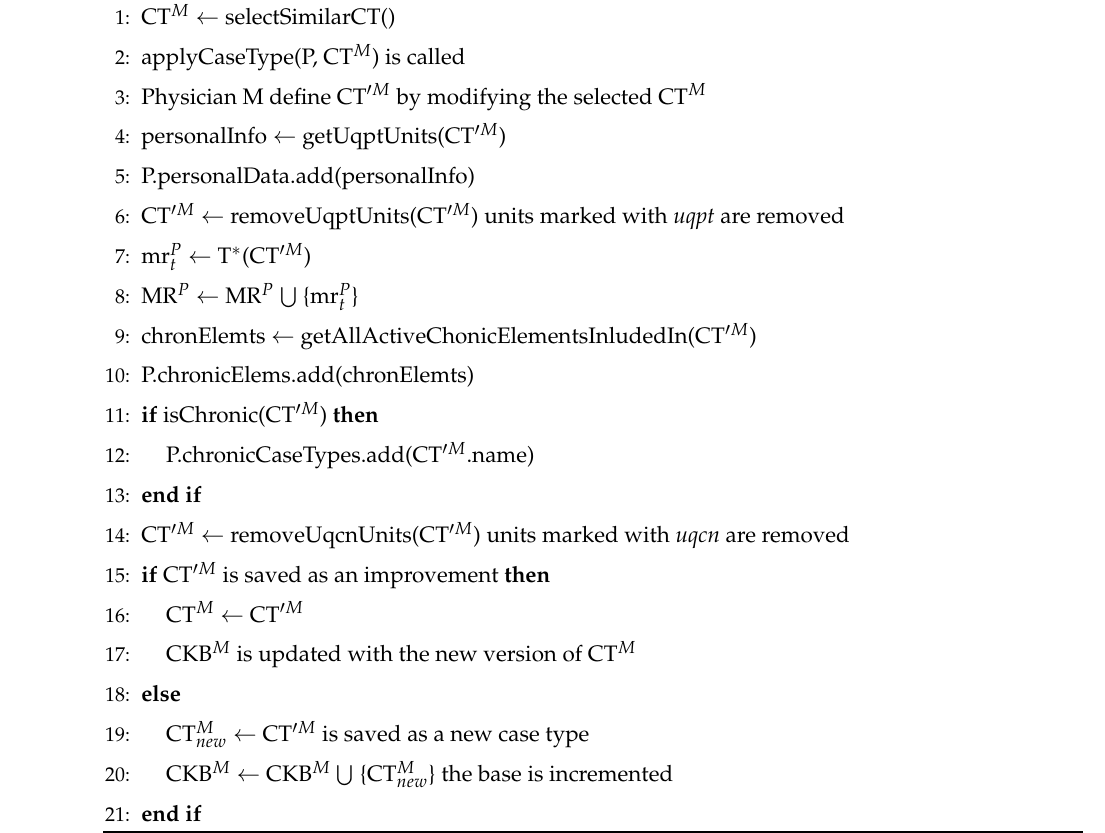
Algorithm 5 Usual attention flow of a patient